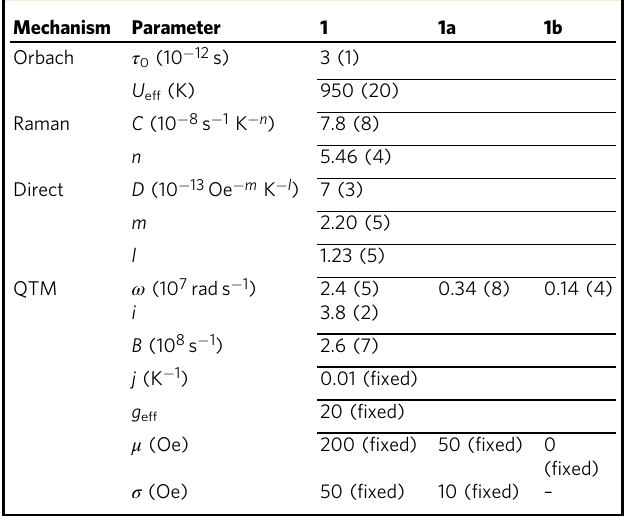
Table 1 Model magnetic relaxation parameters Mechanism Parameter